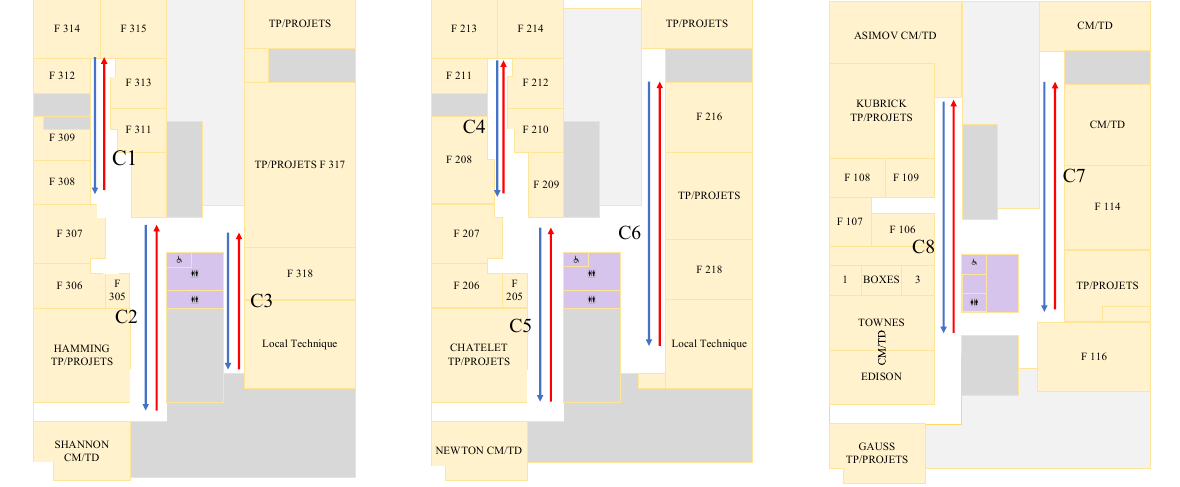
Figure 7. Designed corridors in Polytech Galilee.